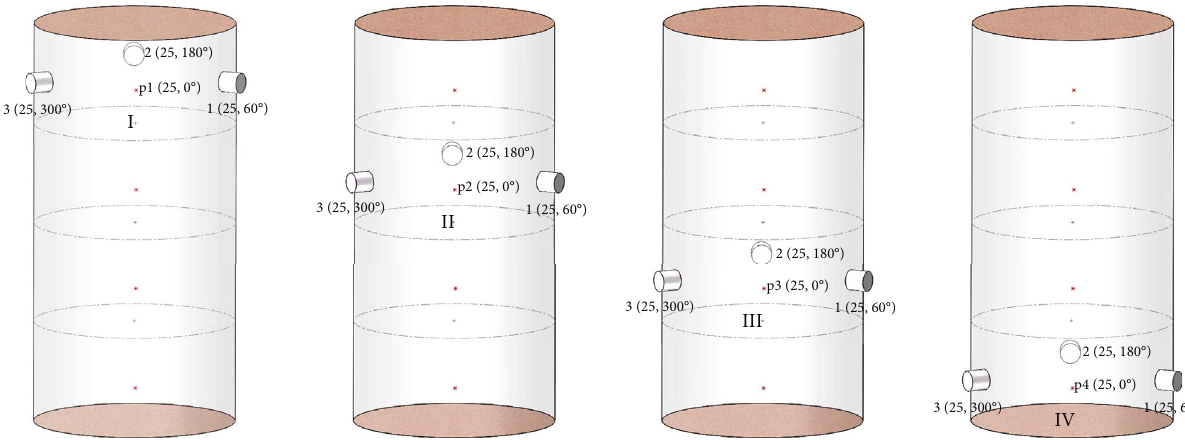
Figure 2: Spatial coordinates of lead break point and sensor.